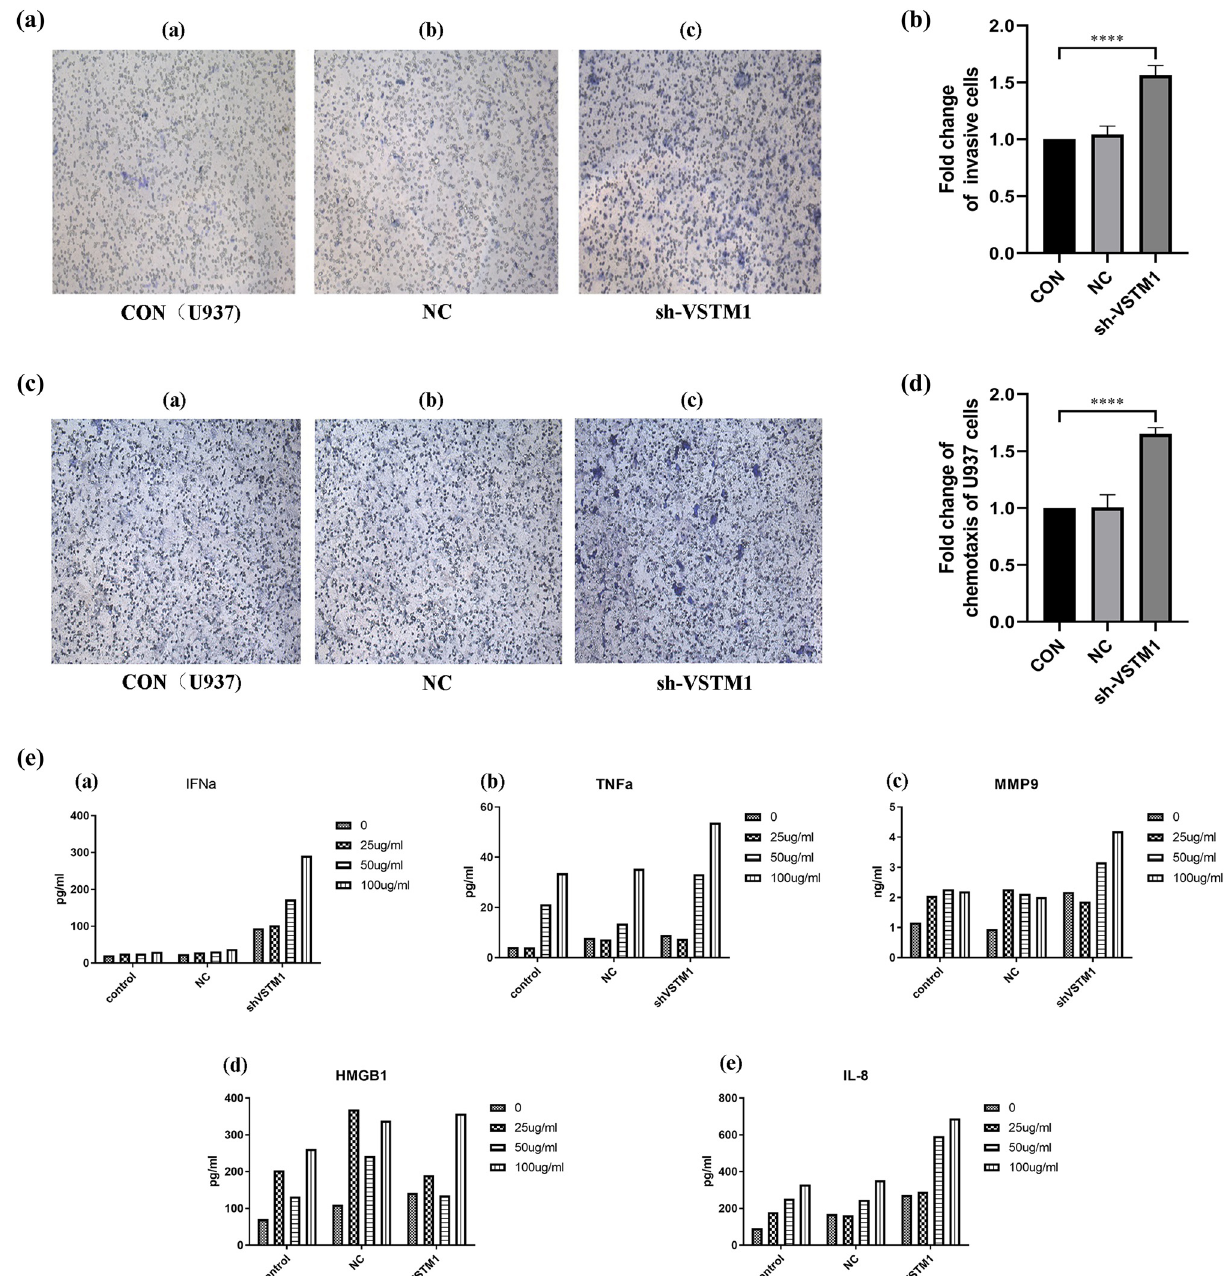
Figure 2: E ff ects of sh - VSTM1 on invasiveness, chemotactic ability, and cellular in fl ammatory response. ( a and b ) Invasion results of U937 , U937 NC, and sh - VSTM1 U937 cells without exposure to ox - LDL ( compared with the 293 T group, * p < 0.05, ** p < 0.01, *** p < 0.001, **** p < 0.0001, n = 5 ) . ( c and d ) Chemotaxis results of U937, U937 NC, and sh - VSTM1 U937 cells without exposure to ox - LDL ( compared with the 293 T group, * p < 0.05, ** p < 0.01, *** p < 0.001, **** p < 0.0001, n = 3 ) . ( e ) IFN - α , TNF - α , MMP - 9, HMGB1, and IL - 8 concentrations in cell supernatant. Statistical analysis was performed using Pearson chi - square test or Fisher ’ s exact test ( n < 5 ) with subsequent multiple comparisons using chi - square with Bonferroni correction for categorical variables. One - way ANOVA with subsequent post hoc multiple comparisons was used for continuous variables with the Student – Newman – Keuls